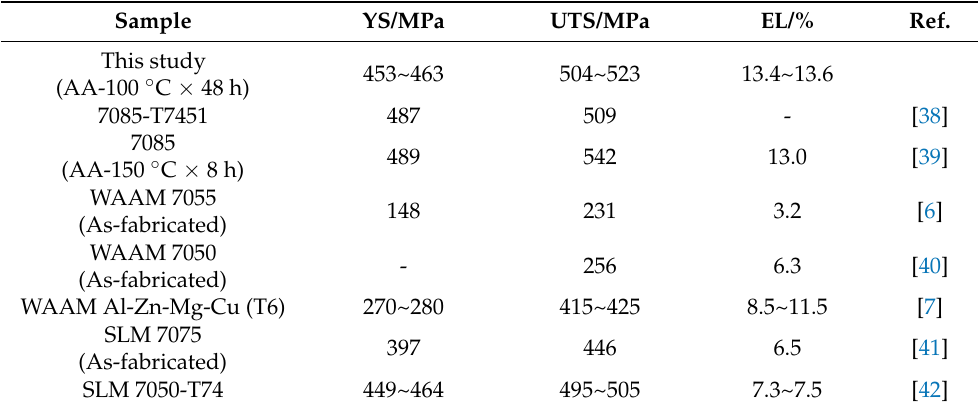
Table 2. Tensile properties of the typical Al–Zn–Mg–Cu alloys and the builds fabricated by different additive